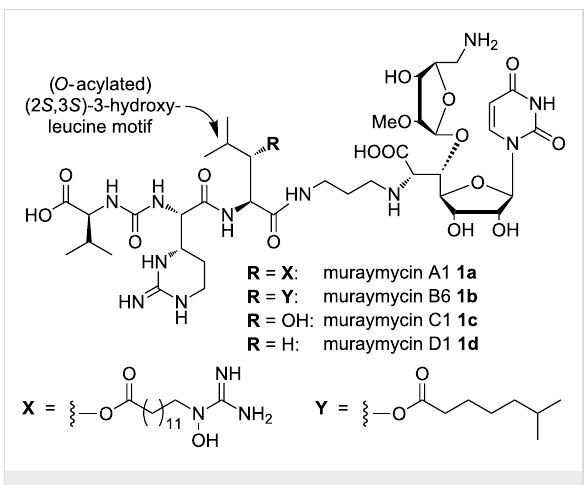
Figure 1: Structures of muraymycins A1, B6, C1 and D1 1a – d